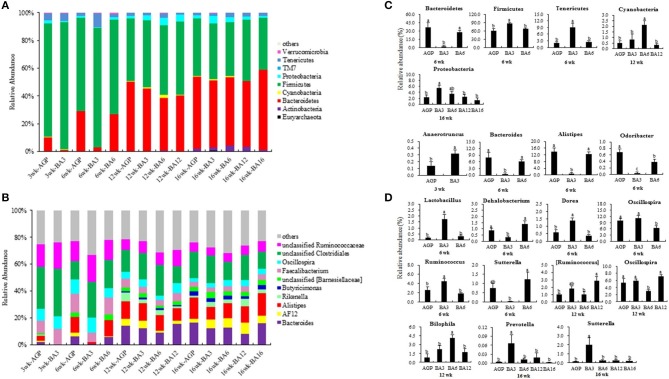
Composition of the caecal microbiome of pullets from different groups. The caecal microbiota at phylum (A) and genus (B) levels, the differentially abundant phylum (C) and genera (D) in caecum of pullets from 0 to 16 weeks (P < 0.05). For (A) and (B), a color-coded bar plot shows the average bacterial phylum and genus distribution in different mixed groups and AGP group from 0 to 16 weeks.